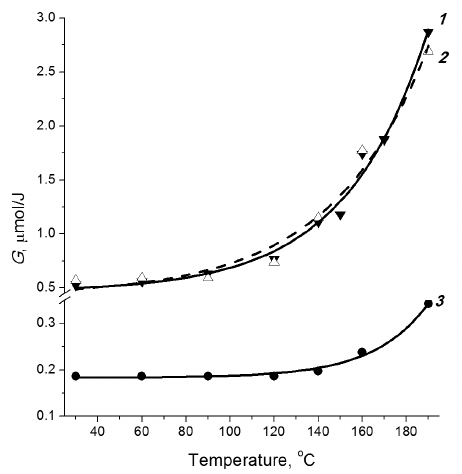
Figure 4. Temperature dependences of cellulose decomposition yield ( 1 ) and formation of carbonyl ( 2 ) and carboxyl groups ( 3 )